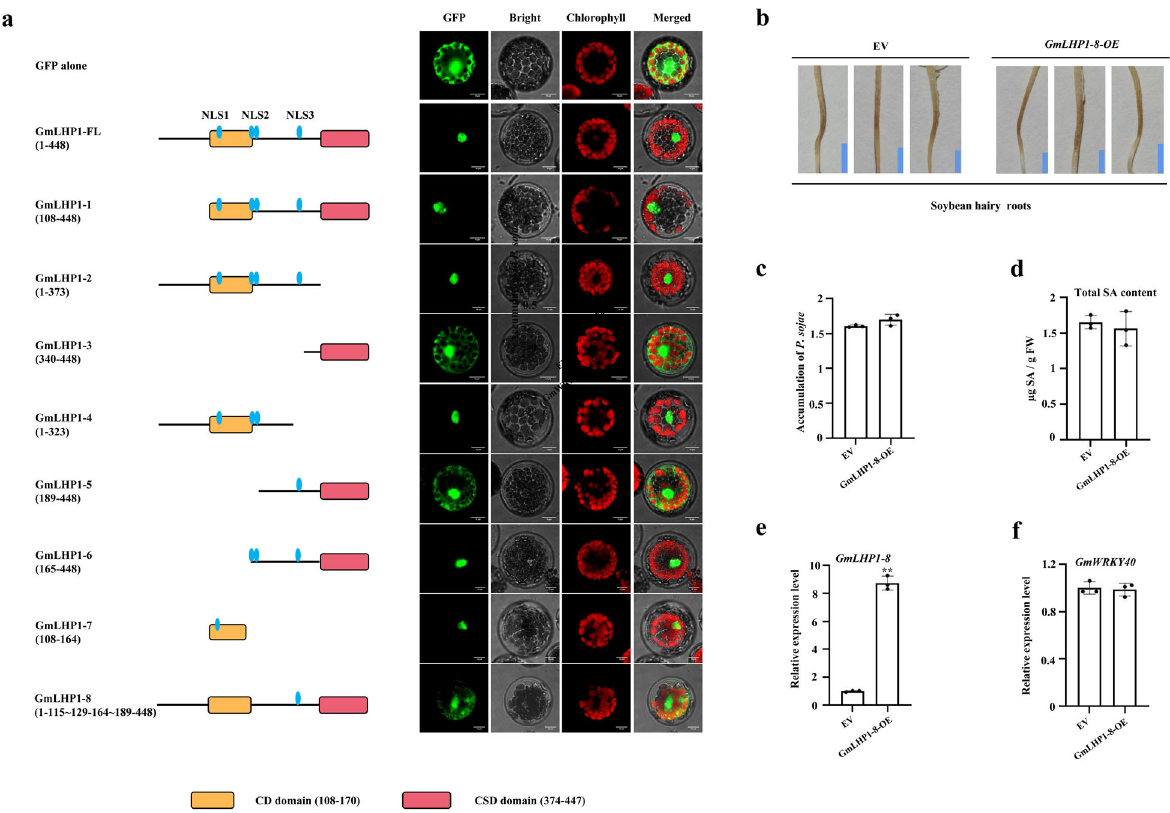
Fig. 6 Deletion analysis of GmLHP1. a Subcellular localization of various GmLHP1 deletion mutants. Left column, scheme of GmLHP1 and its deletion mutants fused to GFP. FL, full length. NLS, nuclear localization signal. Right column, the indicated constructs were transiently expressed in Arabidopsis protoplasts and inspected with a confocal microscope. Scale bars indicate 10 µ m. b Typical infection symptoms of GmLHP1-8-OE and EV soybean hairy roots at 48 h after P. sojae inoculation. Bars, 0.5 cm. c Relative biomass of P. sojae in GmLHP1-8-OE hairy roots based on P. sojae TEF1 (EU079791) transcript levels. d SA contents in GmLHP1-8-OE hairy roots. FW, fresh weight. e GmLHP1-8 transcript levels in EV and GmLHP1-8-OE hairy roots. f GmWRKY40 transcript levels in EV and GmLHP1-8-OE hairy roots. The expression level of the control sample (EV) was set to 1. The housekeeping gene GmEF1 was used as an internal control to normalize the data. The experiment was performed on three biological replicates, each with three technical replicates, and the results were statistically analyzed using Student ’ s t -test (* P < 0.05, ** P < 0.01). Bars indicate the standard deviation of the mean ( n =